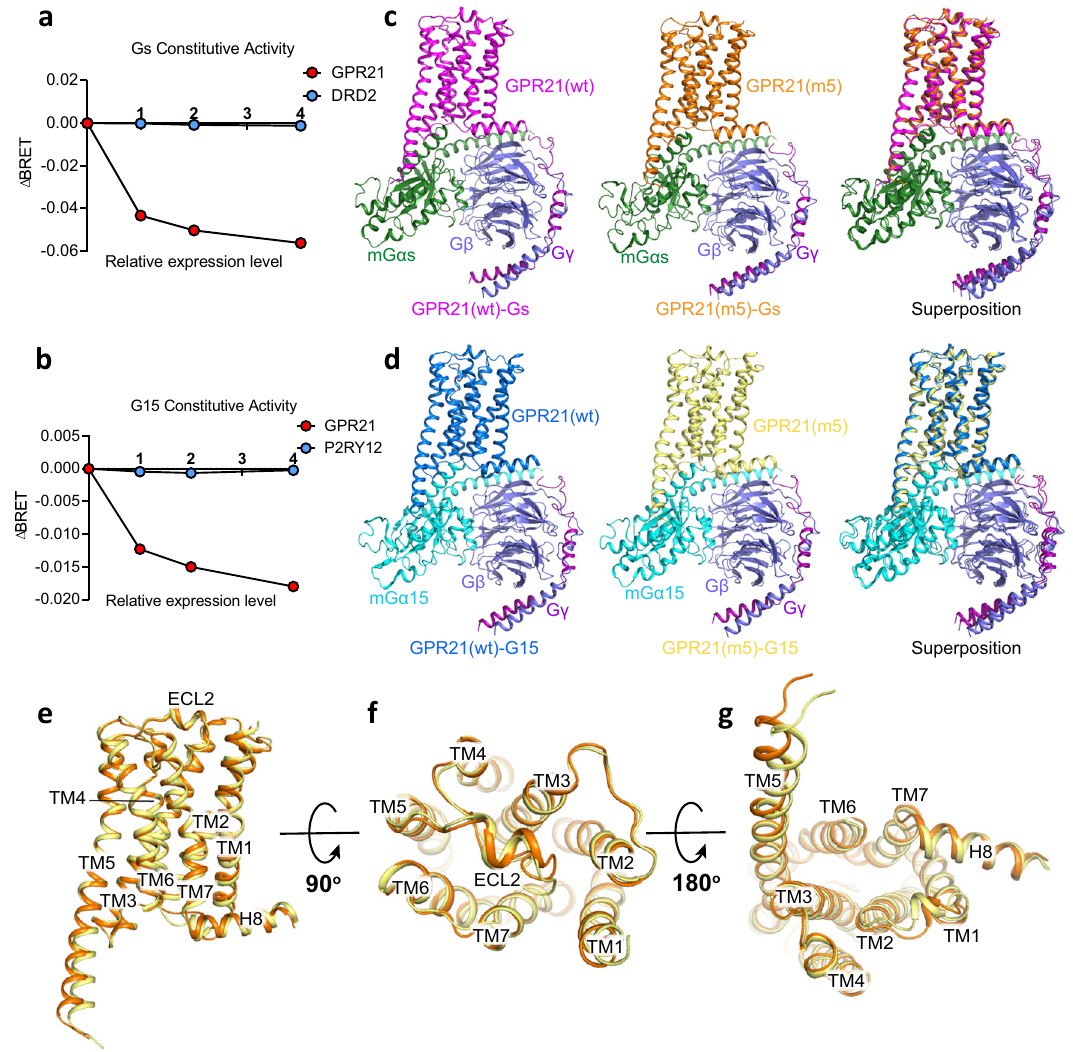
Fig. 1 | Cryo-EM structures of the GPR21-Gs and GPR21-G15 complexes. a Constitutiveactivities of GPR21 receptorin Gs signaling measured by BRETassay (see “ Methods ” ),dopaminereceptor2(DRD2)wasusedasanegativecontrol(blue). The gradient cell surface expression levels of GPR21 receptor and DRD2 were achieved by adjusting the transfecting amounts of plasmids encoding the respec- tive receptor in HEK293 cells. Data were from three independent experiments. Δ BRET: the change of bioluminescence resonance energy transfer value. Source dataareprovidedasaSourceData fi le. b ConstitutiveactivitiesofGPR21receptorin G15 signaling measured by BRET assay (see “ Methods ” ), purinergic Receptor P2Y (P2RY12) was used as a negative control (blue). Data were from three independent